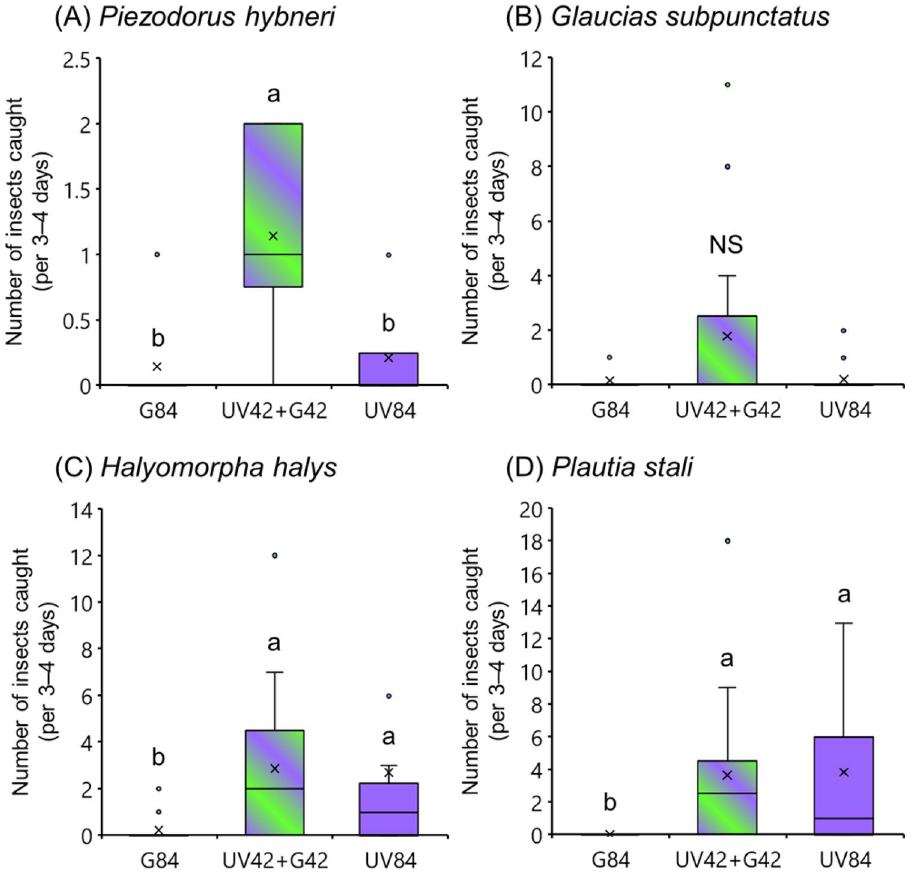
Figure 2. Attractiveness of different light sources to stink bugs. Boxplots represent the median value (horizontal line), mean value (cross mark), interquartile range (boxed area), maximum and minimum values (vertical bar), and outlier value (circle). Different letters above the bars indicate significant differences ( p < 0.05) in Wilcoxon signed-rank test with Bonferroni correction. NS not significant ( p > 0.05). The data shown in these graphs were all obtained from field experiments conducted in